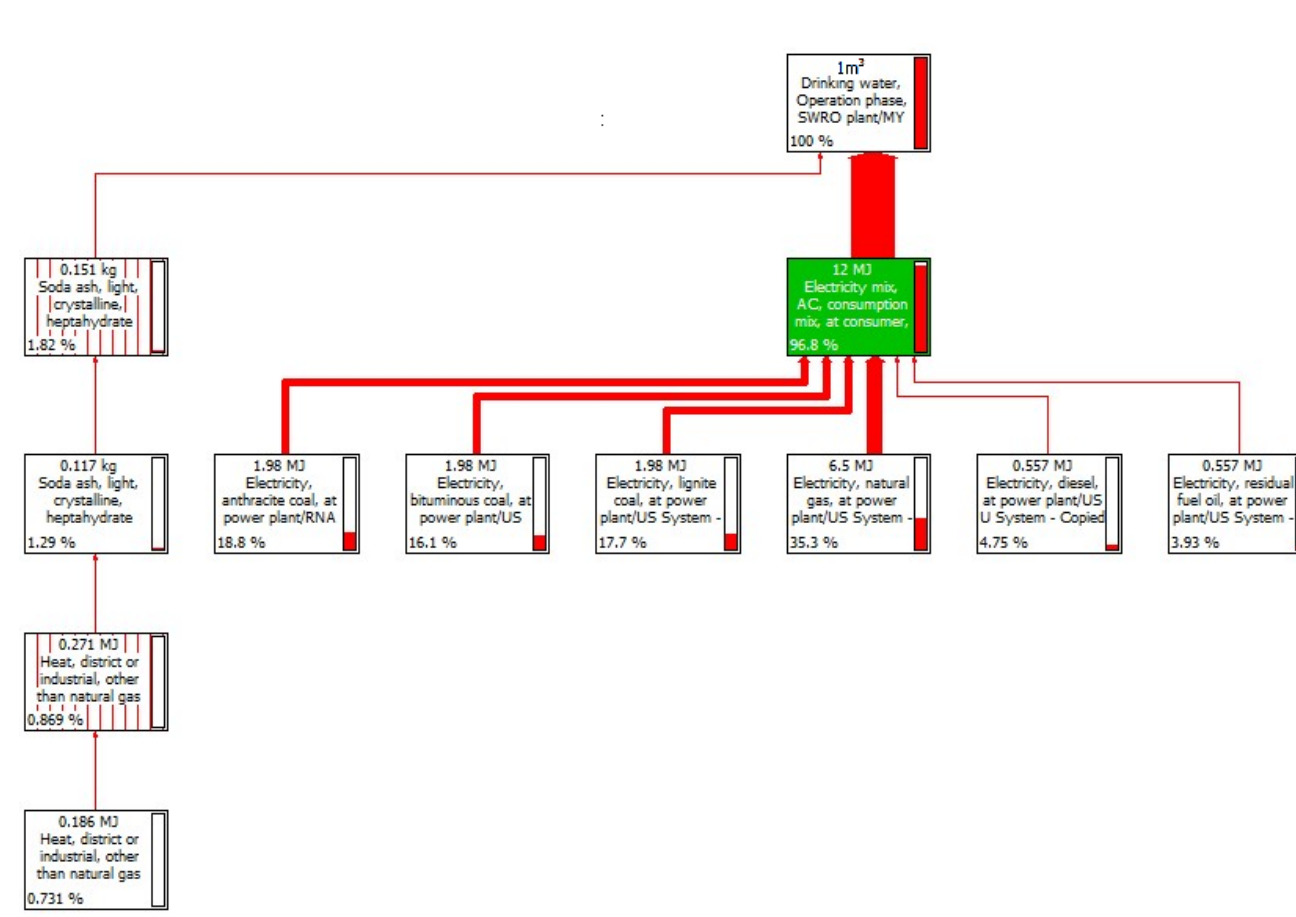
Figure 3. Tree diagram for energy and chemical distribution in SWRO plant.